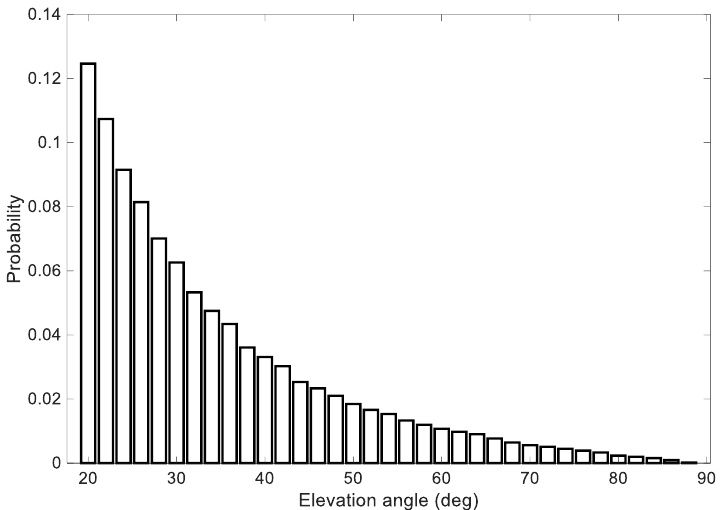
Figure 10. Probability density of the Metop − C satellite elevation angle seen from Spino d’Adda for elevation angles larger than ~20° .